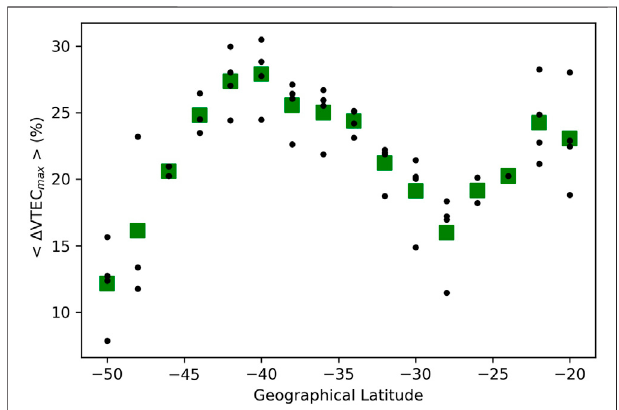
FIGURE 4 | Plot of the observed average of relative Δ VTEC max with geographical latitude. Black dots show individual relative Δ VTEC max values for different longitudes within each latitude bin and green squares indicate average value within each